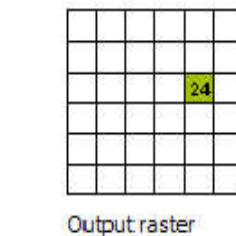
Figure 6: Binary images: dunes in yellow color (a 2005, b